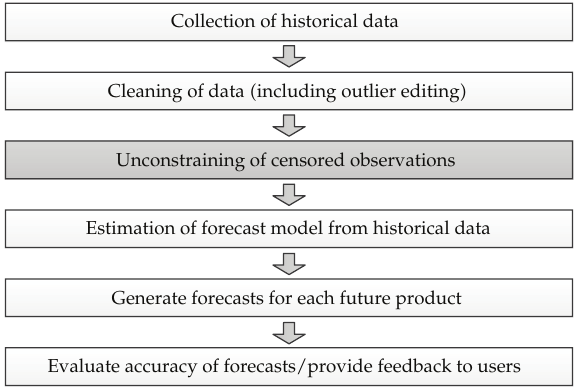
Figure 3: Revenue management forecasting